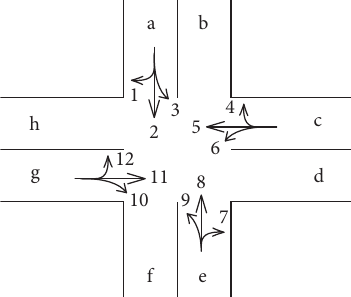
Figure 2: A typical intersection with four connected links is shown in this illustration. Links (a), (c), (e), and (g) are inflow links of this intersection. Drivers on each link have three choices to continue their path: left, right, and straight forward. However, there are four inflow links, each of which has three possible destination links at intersection. Accordingly, an intersection with four connected link provides 12